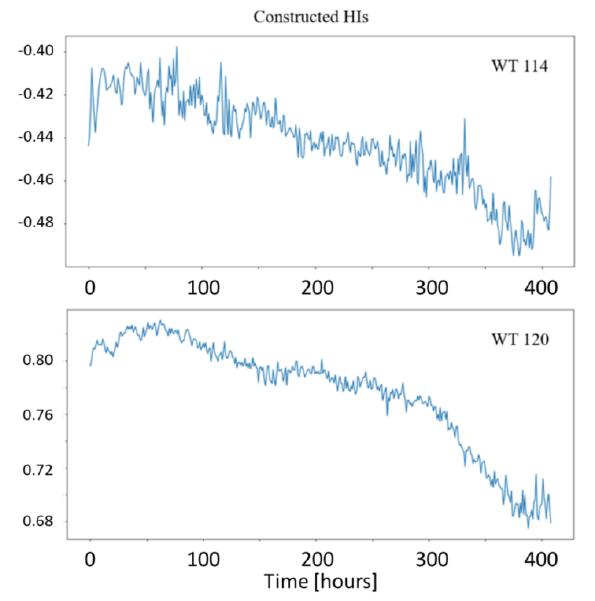
Figure 7. Constructed HIs for WT 114 and 120—last 20 days leading to the gearbox